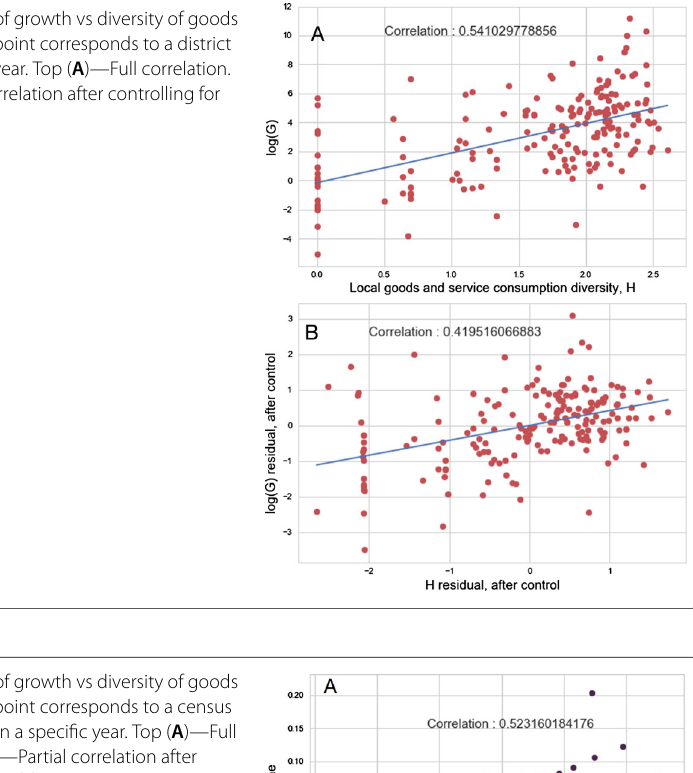
Figure 6 Scatter plot of growth vs diversity of goods consumed. Each data point corresponds to a census block in United States in a specific year. Top ( A )—Full correlation. Bottom ( B )—Partial correlation